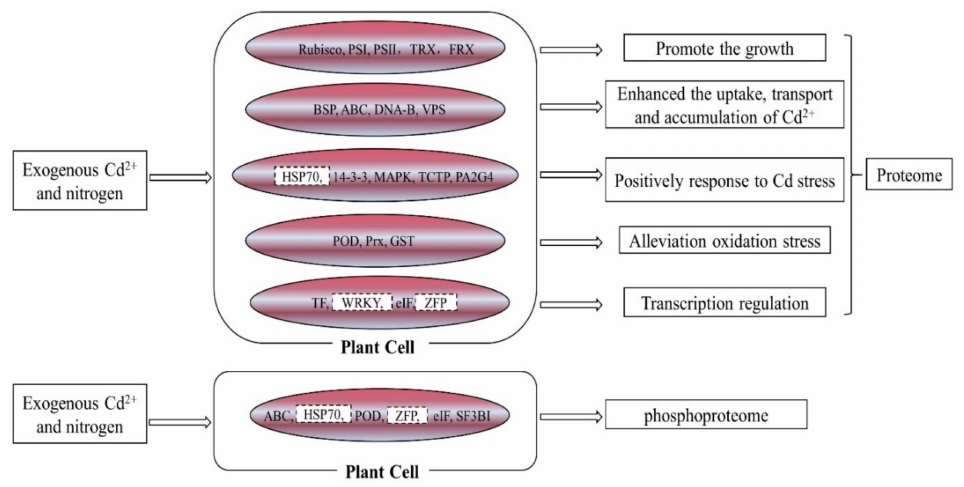
Figure 6. Exogenous nitrogen alleviated the toxicity of cadmium to poplar plants through multiple channels. Red, up-regulated protein; PS I, Photosystem I; PS II, photosystem II; TRX, thioredoxin family protein; FRX, ferredoxin family protein; ABC, ABC transporter protein; DNA-B, DNA-binding protein; HSP70, heat shock protein 70; 14-3-3, 14-3-3 protein; MAPK, Mitogen-activated protein kinase; TCTP, translationally controlled tumor-like family protein; PA2G4, proliferation-associated protein 2G4-like; POD, Peroxidase; Prx, Peroxiredoxin; GST, glutathione transferase; TF, transcription factor; elF, Eukaryotic translation initiation factor; ZFP, zinc finger protein; SF3BI, splicing factor 3B subunit 1-like. WRKY, ZFP and HSP70 were selected as the key regulation